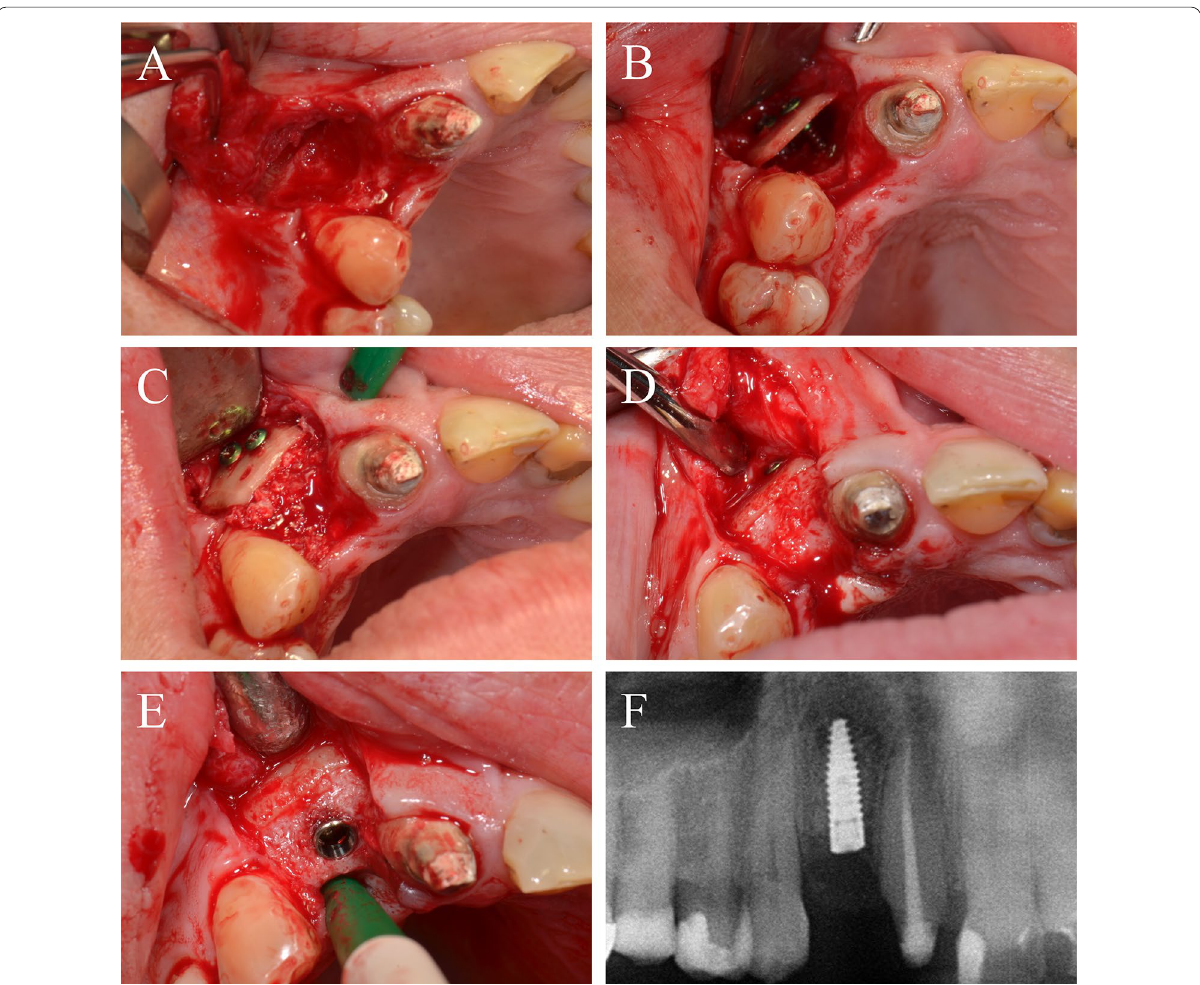
Fig. 5 Alveolar ridge augmentation of the anterior maxilla. A Initial intraoperative situation demonstrating an extended tub-shaped alveolar defect after a failed augmentation attempt using an autogenous graft from the mandibular angle and postoperative hypesthesia of the mandibular nerve. B An allogeneic cortical bone plate was placed and fixed by adjusting screws. C The occurred space was filled with allogeneic spongious granules. D Four months later, a sufficient bone bed was found and E a bone level tapered implant was inserted. F X-ray demonstrating the inserted